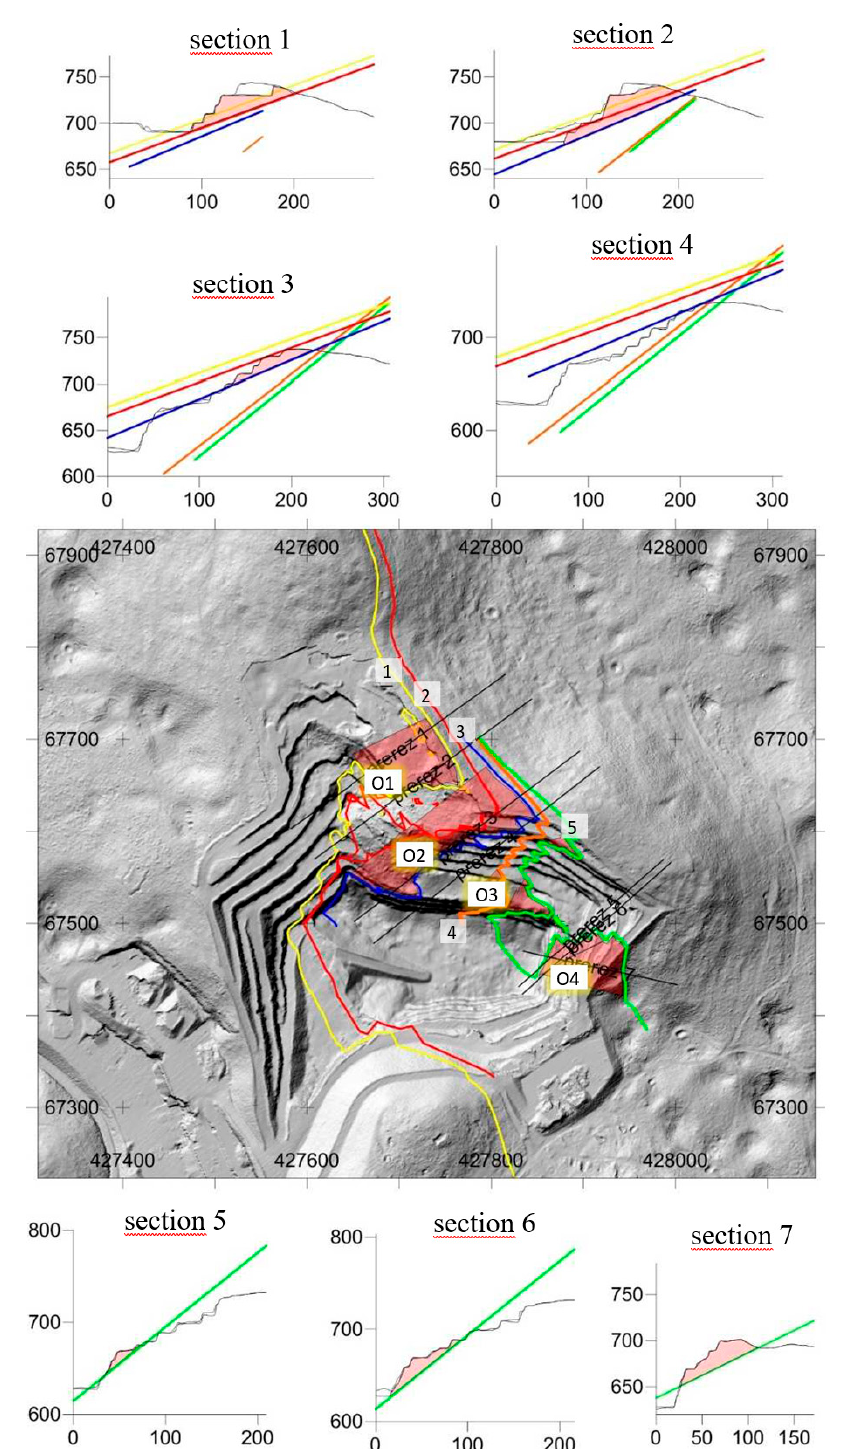
Figure 8. The locations of major discontinuities (numbers 1 to 5) and critical areas in the quarry (numbers O1–O4) are marked in red.